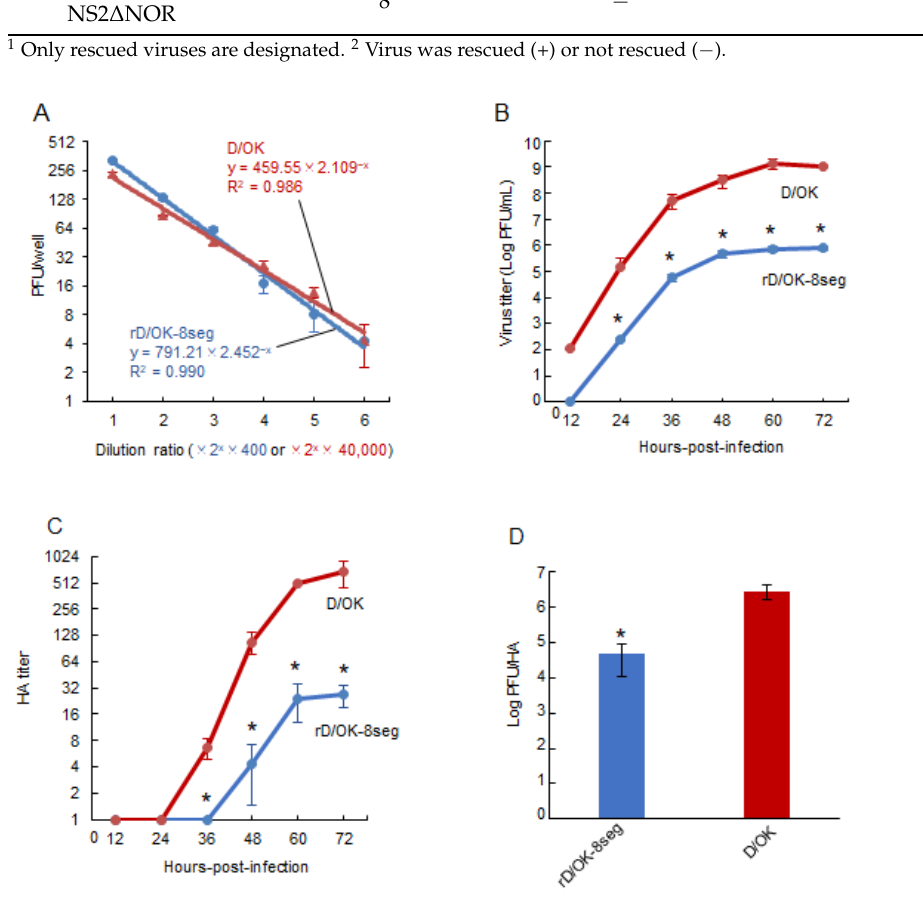
. Figure 2. Growth properties of rD/OK-8seg. ( A ) We evaluated the correlation between dilution ratio and number of plaques in the diluents of rD/OK-8seg or D/OK, where two-fold dilutions from 400-fold for the former or 40,000-fold for the latter, respectively, were employed. Plaque numbers at each dilution are expressed as the mean titer with standard deviations ( n = 3). The coefficient of determination (R2) was determined by regression analysis for each virus. Growth kinetics of rD/OK-8seg and D/OK was examined in ST cells (MOI of 0.0001). Viral titers were determined at 12 h intervals post-infection by ( B ) plaque assay or ( C ) HA assay and reported as the mean titer with standard deviations ( n = 3). ANOVA (a linear mixed model) indicated the significance of the differences ( p < 0.01) between growth kinetics of rD/OK-8seg versus D/OK by each assay. The asterisks indicate significant differences at each time-point ( p < 0.05 by Holm test as a post hoc test). ( D ) PFU/HA ratios were determined in rD/OK-8seg and D/OK stocks in ST cells at 60 h post-infection (MOI of 0.0001) and reported as the mean titer with standard deviations ( n = 3). The significance of the differences ( p < 0.05) between two viruses was evaluated by the two-tailed Student- t